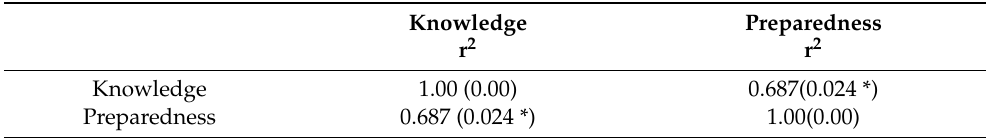
Table 6. Relationship between knowledge and their preparedness regarding infection control against COVID-19.